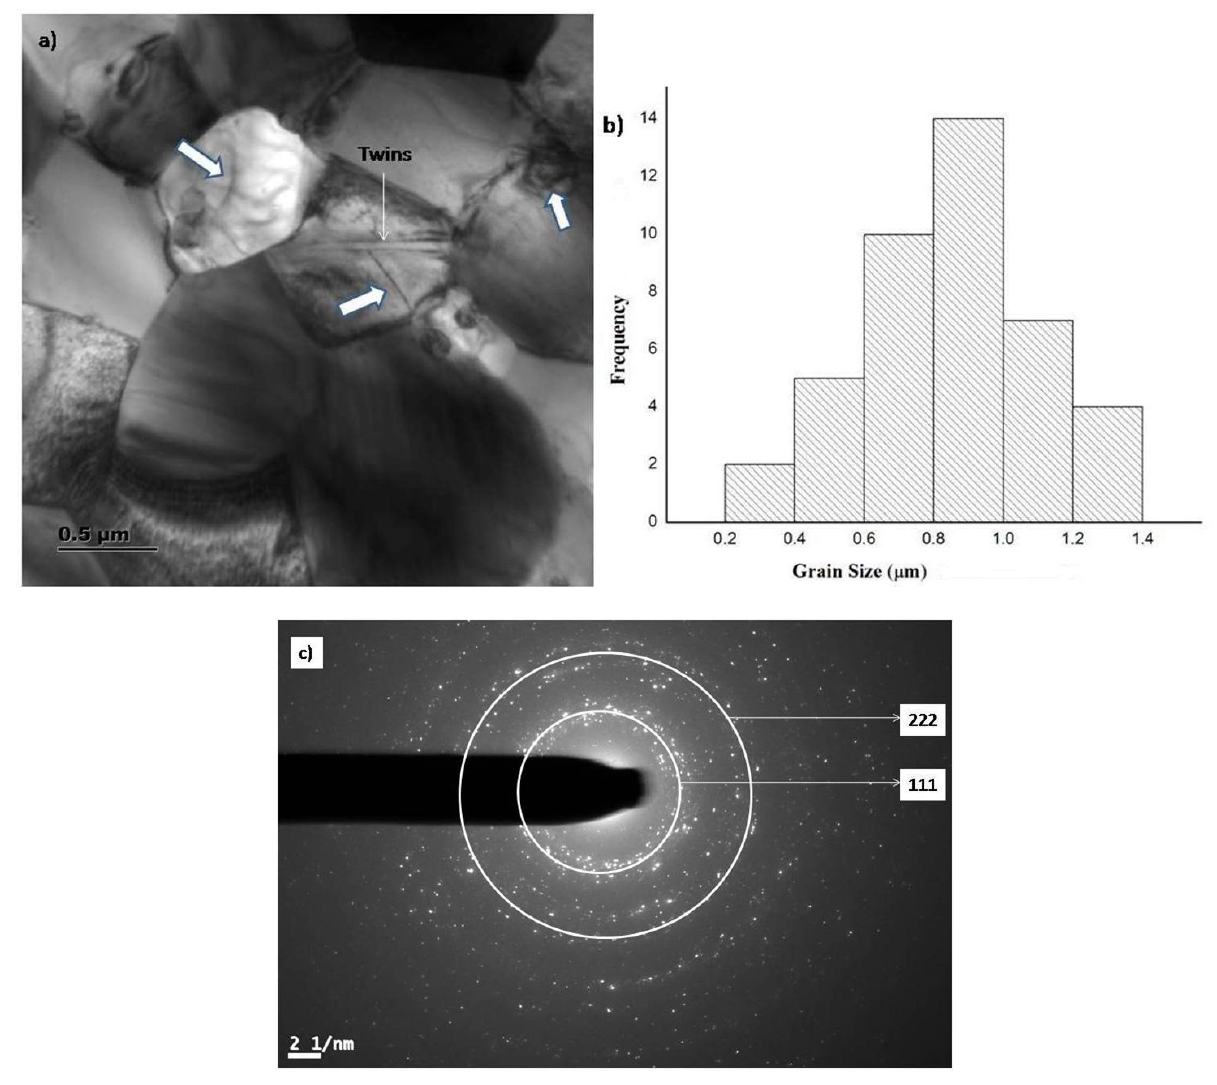
Figure 9. TEM micrograph of heat resistant austenitic steel of 21-4N ( a ) bright field image where arrow mark indicates dislocation lines, ( b ) distribution of grain size for the austenitic matrix, ( c ) corresponding SAD pattern.